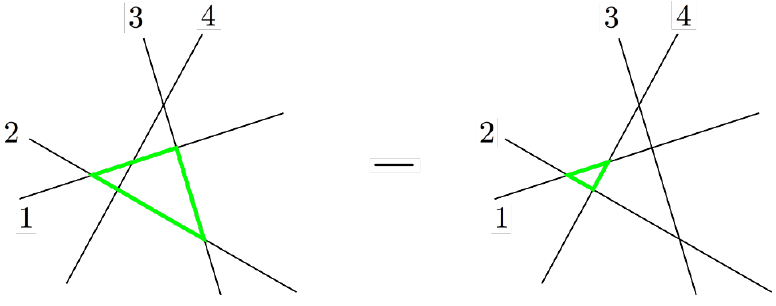
Figure 4 . The quadrilateral shown in (cid:12)gure 3 viewed as the di(cid:11)erence of two